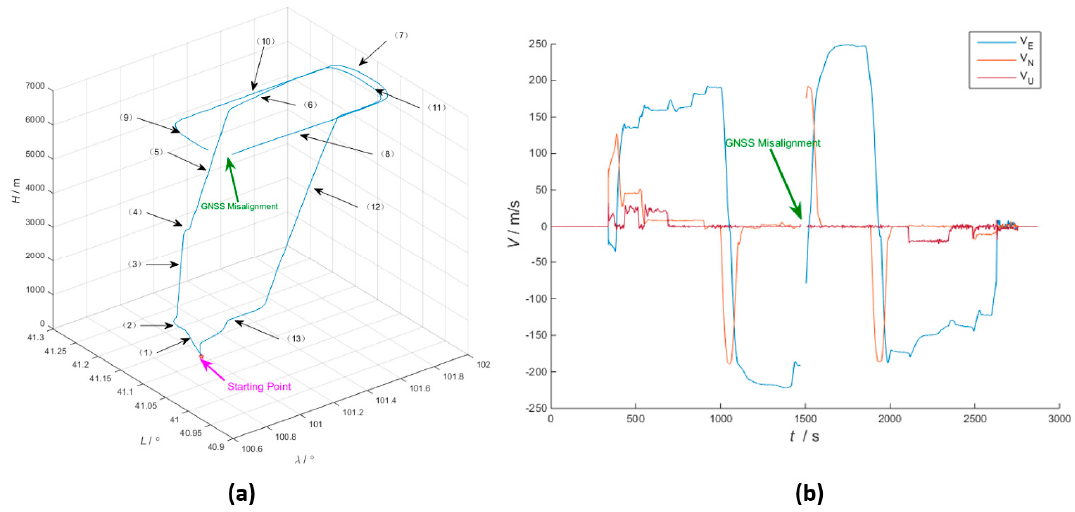
Figure 5. ( a ) 3D trajectory diagram; ( b ) diagram of eastward velocity, northward velocity and upward velocity.